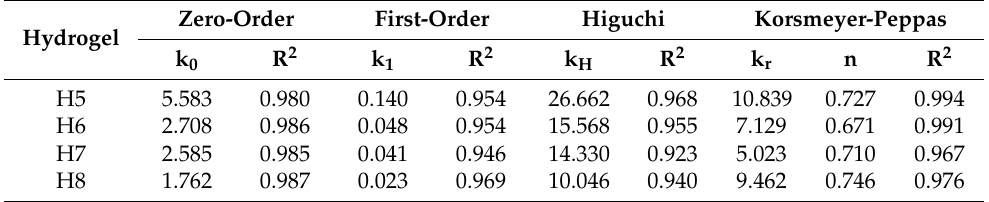
Table 3. Kinetic and mechanism models’ constants and correlation coefficient, R 2 of SSD release. Zero-Order First-Order Higuchi Korsmeyer-Peppas Hydrogel k